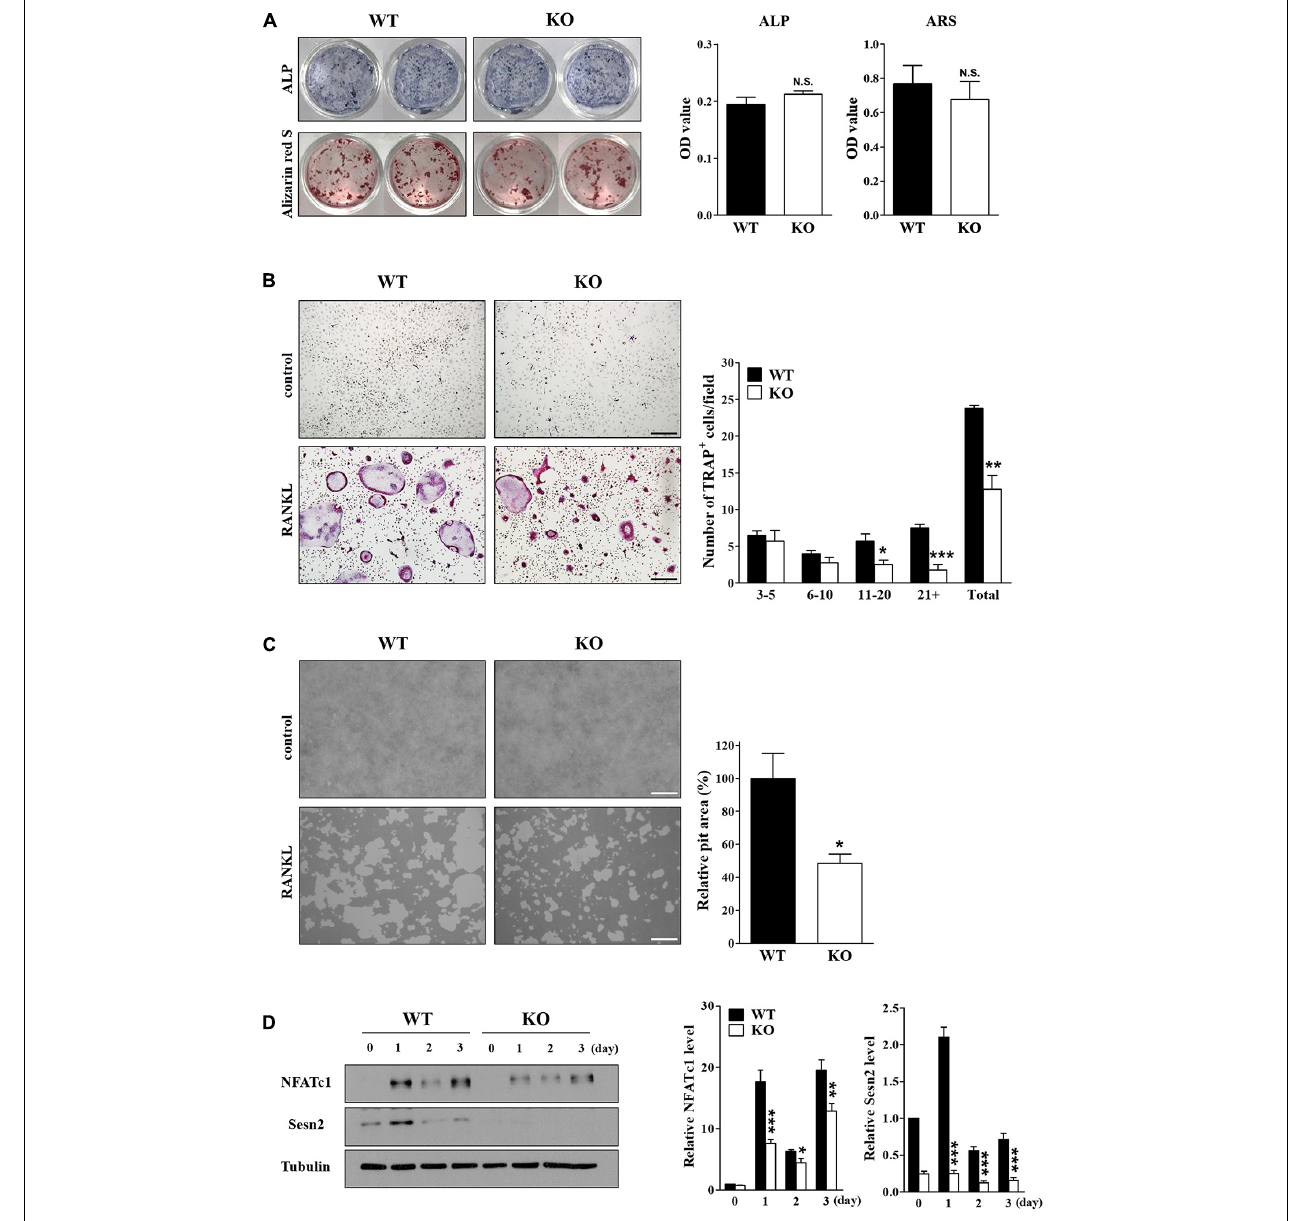
FIGURE 2 | Deletion of Sesn2 inhibits osteoclast differentiation. (A) Primary calvarial osteoblasts derived from WT and Sesn2 KO mice were stained for ALP and ARS after 14 day of cell culture ( n = 4). The Sesn2 deletion had no effects on osteoblast differentiation in Sesn2 KO mice. N.S. = not significant. (B) Primary BMMs derived from WT and Sesn2 KO mice were TRAP-stained after 6 days of cell culture ( n = 4). After staining, TRAP + MNCs with more than three nuclei were scored as osteoclasts. Osteoclast differentiation was reduced in Sesn2 KO mice (Scale bar = 50 µ m). Data were expressed as mean ± S.E.M. * p < 0.05, ** p < 0.01, and *** p < 0.001 compared with RANKL-treated WT mice. (C) BMMs were plated on a pit assay plate and cultured for 6 days ( n = 4). The attached cells were removed and photographed under a light microscope. Pit areas were quantified using Bio-Quant software (Scale bar = 50 µ m). RANKL-induced bone resorption was inhibited in Sesn2 KO BMMs. The data were normalized to the resorptive area in RANKL-treated BMMs from WT mice. Results were expressed as mean ± S.E.M. * p < 0.05 compared with RANKL-treated WT mice. (D) Expression of NFATc1 (90 ∼ 110 kDa), Sestrin2 (54 kDa), and tubulin (50 kDa) in WT and Sesn2 KO BMMs after RANKL stimulation were quantified by immunoblotting and ImageJ analysis ( n = 6). Expression of NFATc1 was lower in Sesn2 KO BMM cells than in WT BMM cells. Data were normalized to the expression in cells from WT mice and expressed as mean ± S.E.M. * p < 0.05, ** p < 0.01, and *** p < 0.001 compared with WT.